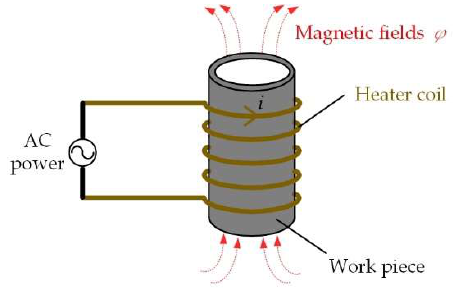
Figure 1. Diagram showing the principle of induction